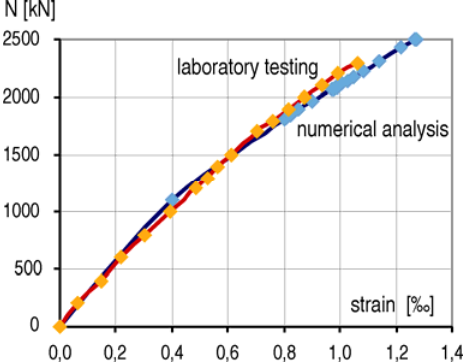
Fig 14 . Load-strain characteristic for the section in middle of the length of a composite column